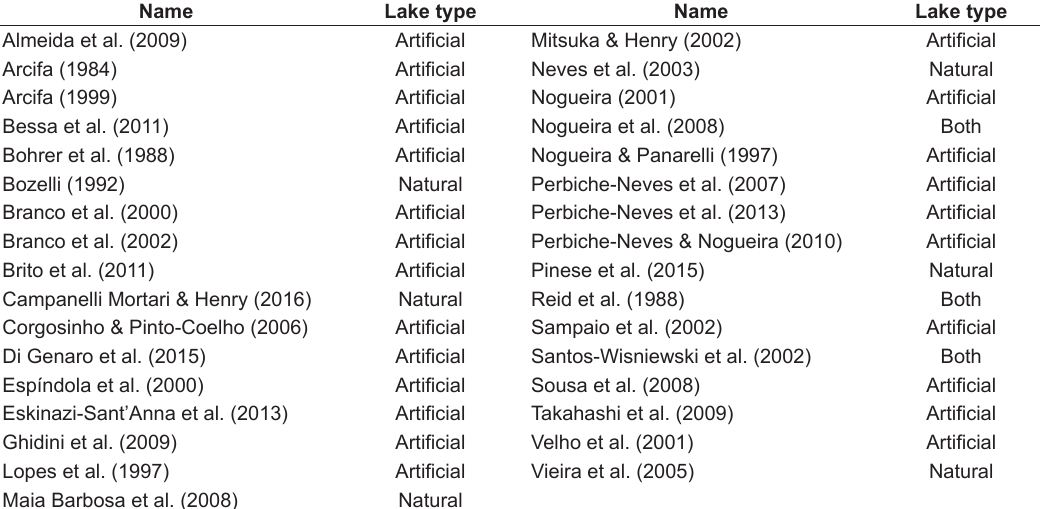
Table 1. List of studies used in our